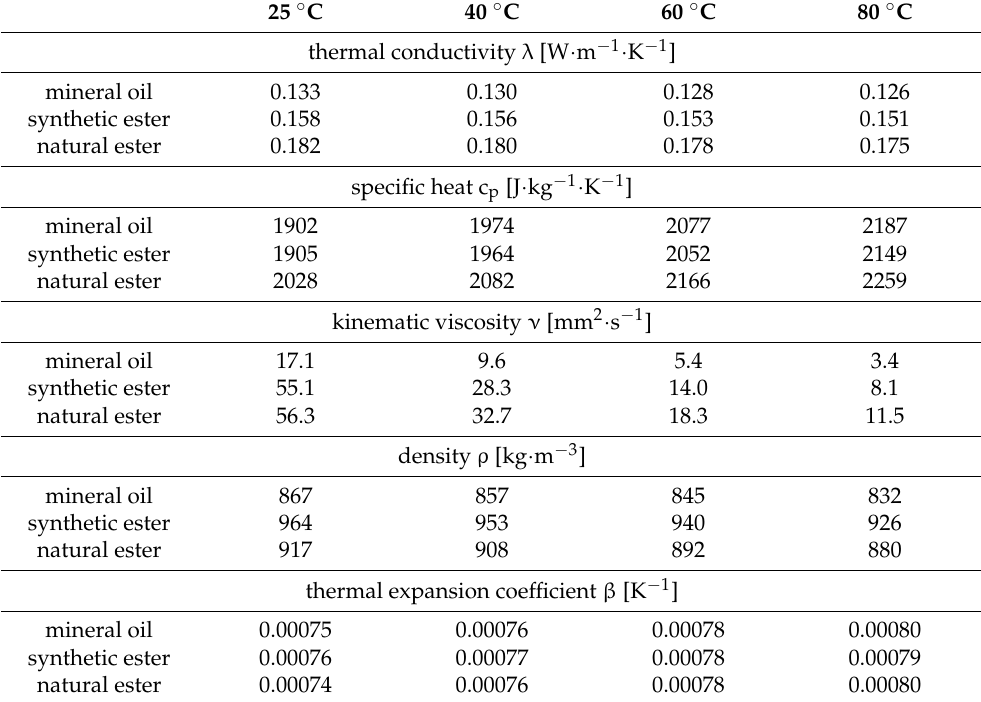
Table 2. Thermal properties of analysed electrical insulating liquids depending on temperature